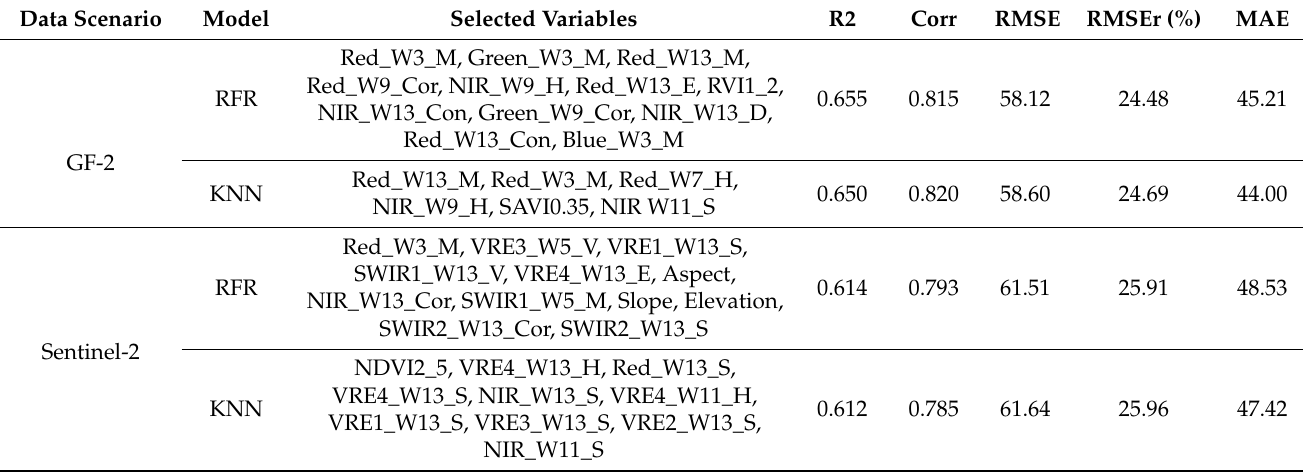
Table 6. Accuracy assessment of GSV estimation (m 3 /ha) based on GF-2 and Sentinel-2 (S2) image data from the RFR or KNN models with various feature variables selected by the AFCO method. W–texture window size (3 × 3, 5 × 5, 7 × 7, 9 × 9, 11 × 11, 13 ×